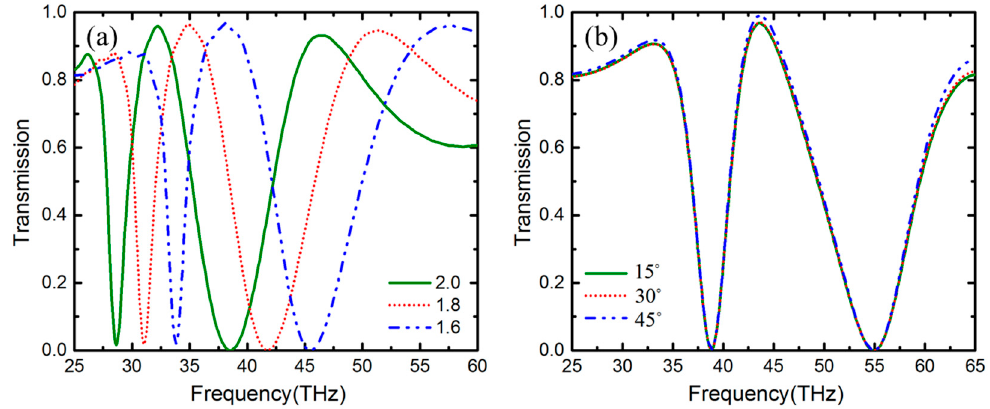
Figure 7. ( a ) Transparency spectrum for different Fermi energy of graphene from 0.5 to 0.7 eV. ( b ) Slow light region corresponding to different Fermi energy of graphene.